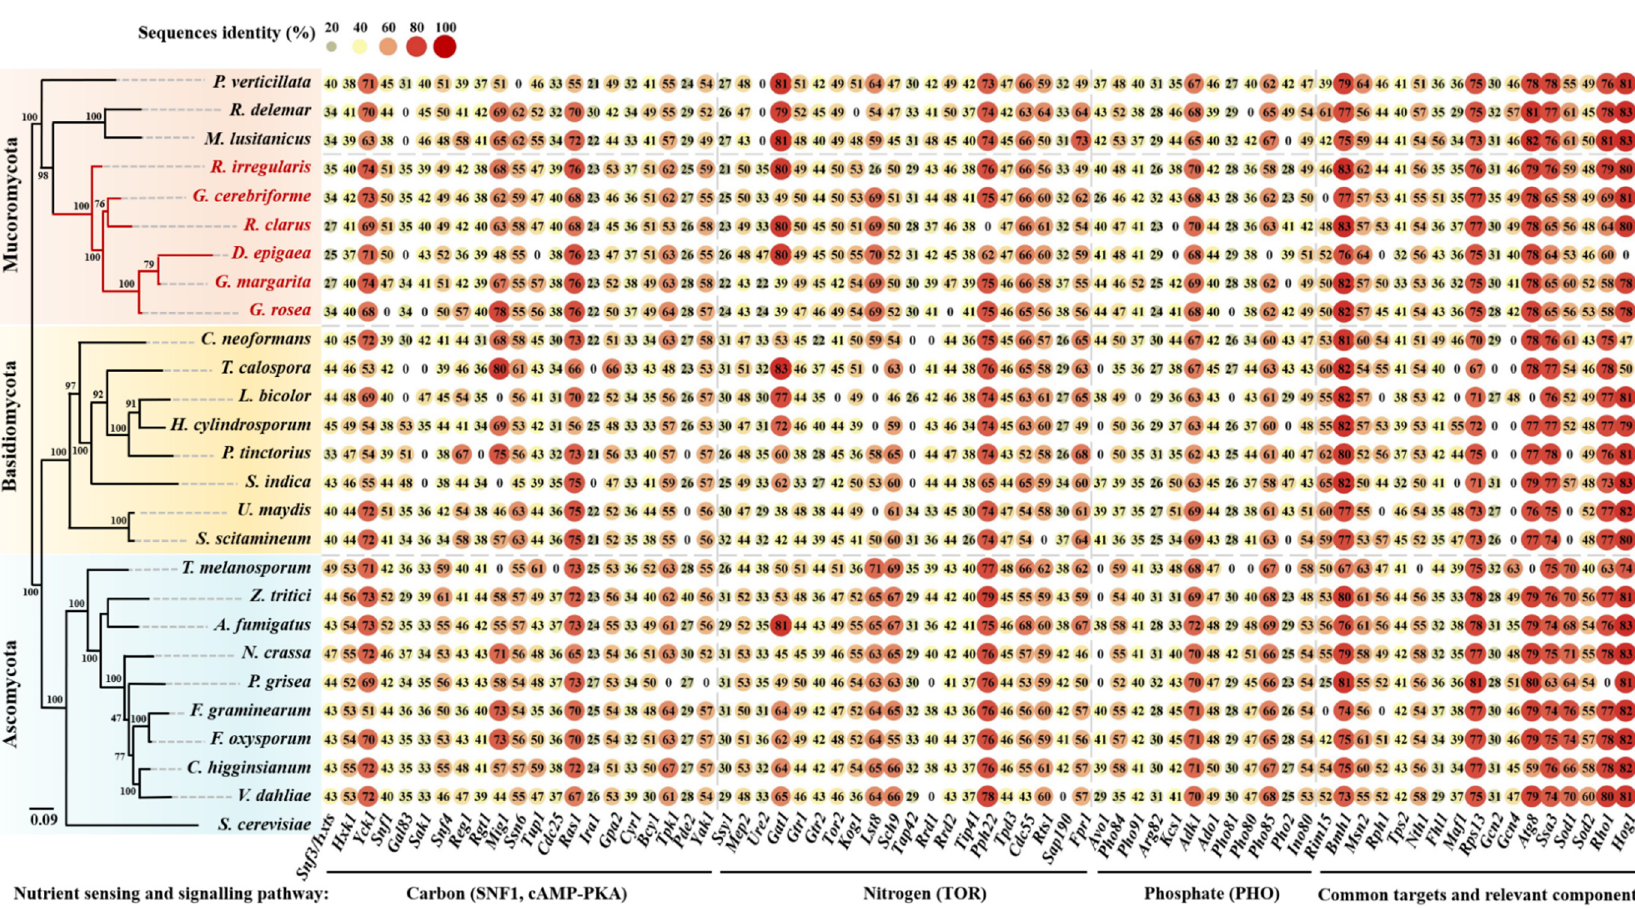
Figure 1. Heatmap of sequences identities. Amino acid sequences of the 70 components of nutrient sensing and signaling pathways in the 26 fungal genomes share identities with those in S. cerevisiae . The data (as a percentage, %) in dots represent the identities that were carried out when the sequences derived from yeast were used as the queries for genome BLAST searching. All hits producing identities greater than 20% and E-values below 10 − 4 were analyzed. The phylogenetic tree was reconstructed from the concatenated alignment of these genes using maximum-likelihood (ML) algorithms (RAxML) with the LG + I + G4 + F substitution model. The heatmap of identities was visualized by the TBtools [63]. Local BLAST results and detail information including accession numbers are shown in Supplemental Table S1.